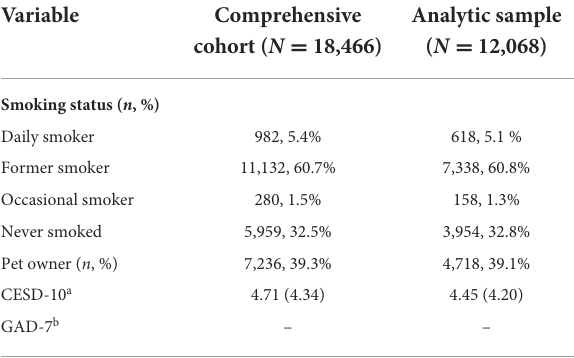
TABLE 2 Analyzed sample participant characteristics at first follow-up (2015–2018) based on pet